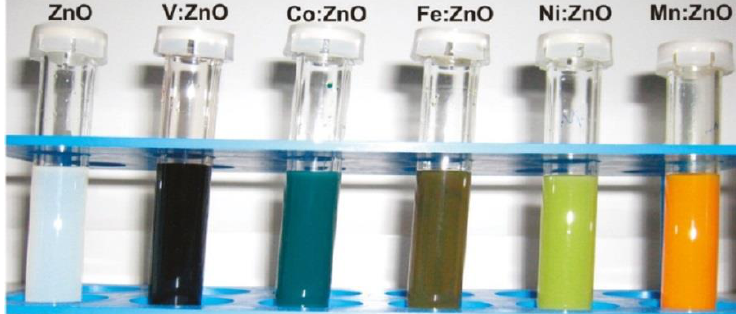
Figure 46. Photographs of ZnO NPs dispersions in benzyl alcohol with different colours depending on the composition. Reprinted (adapted) with permission from [810]. Copyright © 2011, American Chemical Society. All rights reserved. In order to re-use permission must be obtained from the rightsholder.